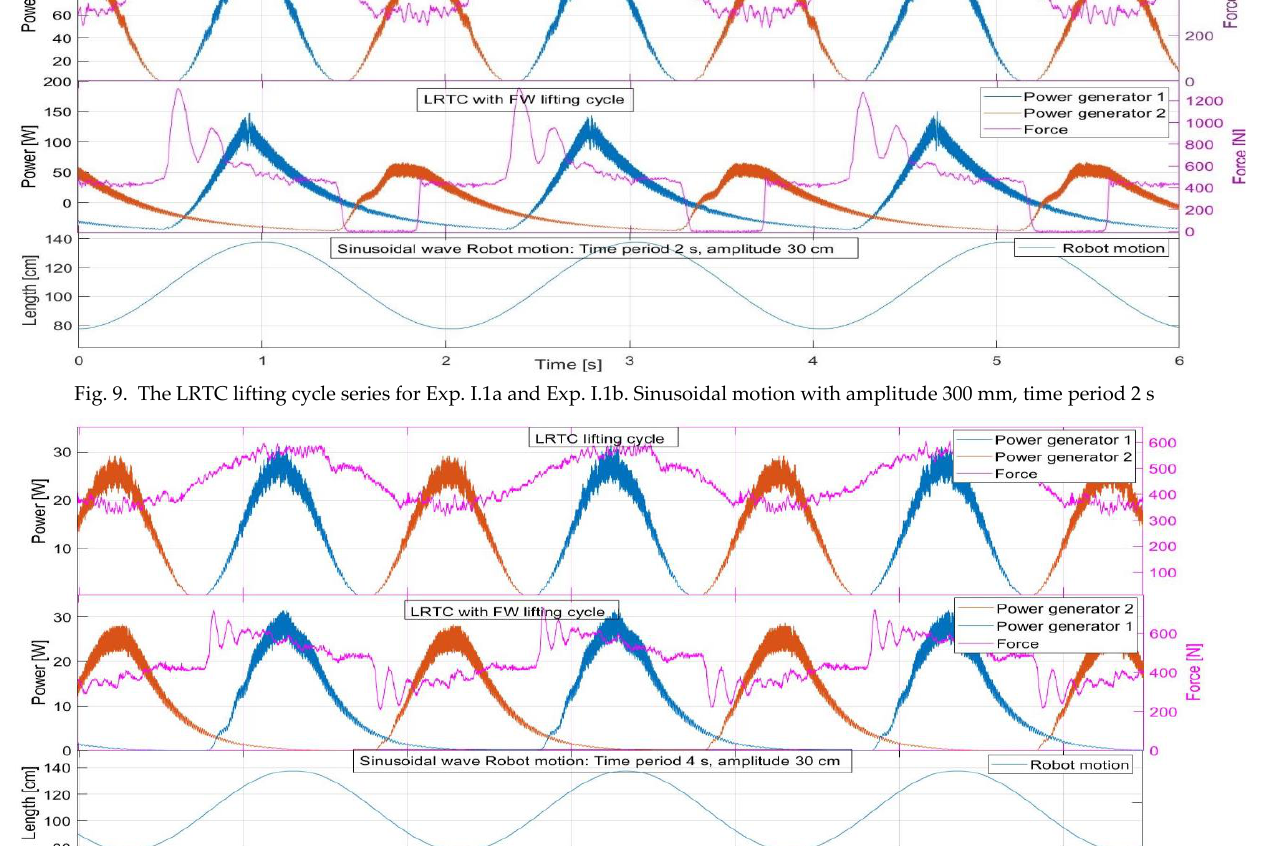
Fig. 10. The LRTC lifting cycle series for Exp. I.2a and Exp. I.2b. Sinusoidal motion with amplitude 300 mm, time period 4 s